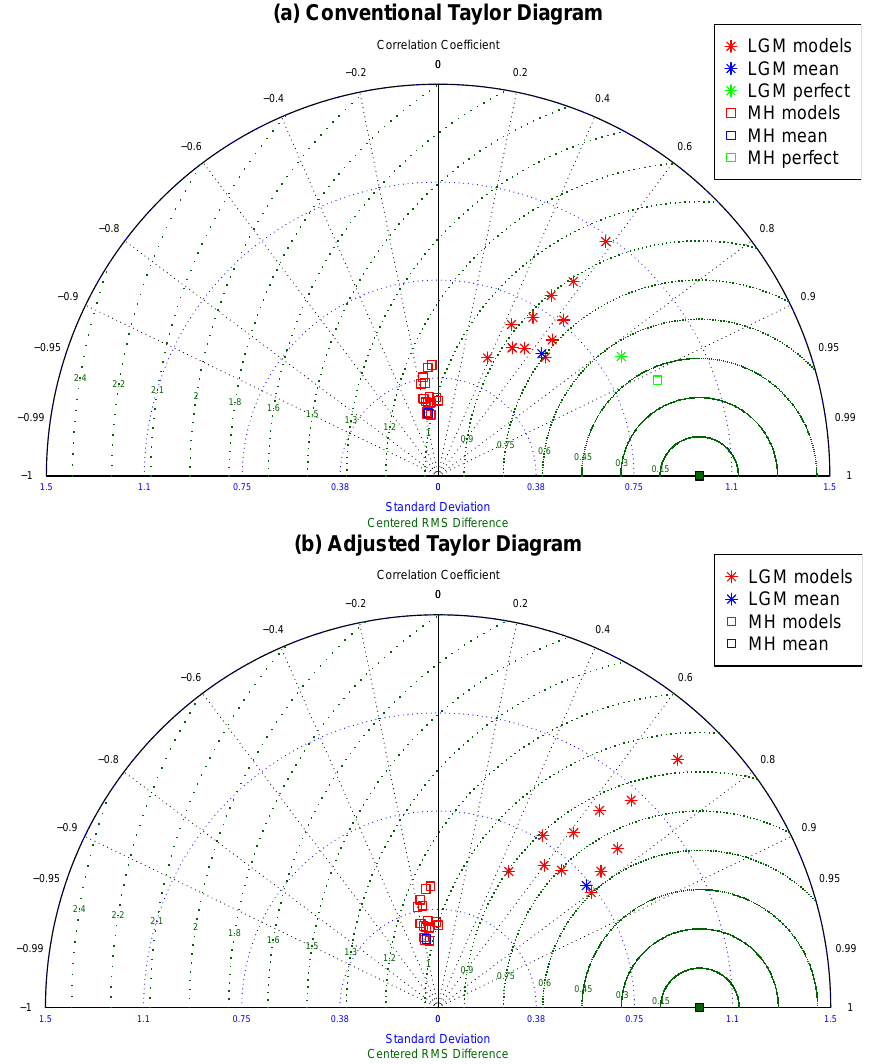
Fig. 6. Taylor diagrams for the LGM mean temperature anomaly and MH hottest month anomaly. Distance from origin indicates standard deviation of field, distance from reference point indicates centred RMS difference between model and data, and pattern correlation is given by the azimuthal coordinate. The left plot shows conventional analysis, with the location of the “perfect model” indicated for comparison. The right plot shows the analysis where model statistics are corrected to account for observational errors. All results are normalised by the standard deviation of the data